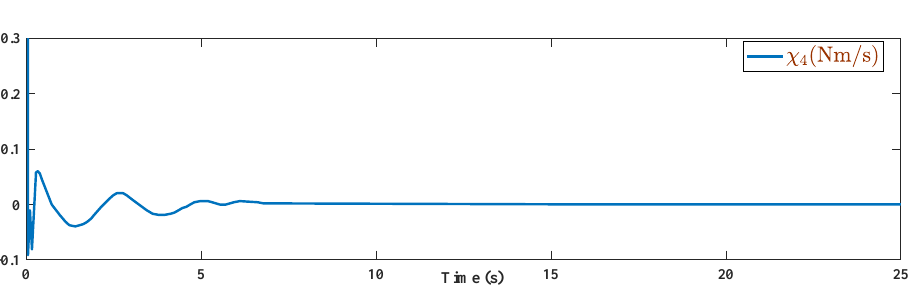
Figure 8. Time response of x 3 related to Scenario 1.